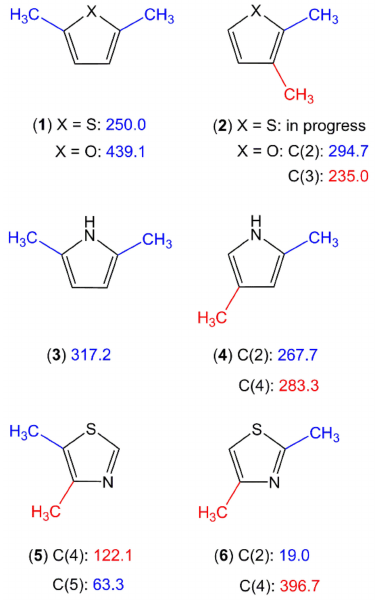
Figure 10. Torsional barriers of the ring methyl rotors in dimethyl-substituted planar five- membered rings (in cm − 1 ). ( 1 ) X = O: 2,5-dimethylfuran [88], X = S: 2,5-dimethylthiophene [89], ( 2 ) X = O: 2,3-dimethylfuran [190], X = S: 2,3-dimethylthiophene, ( 3 ) 2,5-dimethylpyrrole [87], ( 4 ) 2,4- dimethylpyrrole [191], ( 5 ) 4,5-dimethylthiazole [85], and ( 6 ) 2,4-dimethylthiazole [192]. Methyl Substitution on a Substituent